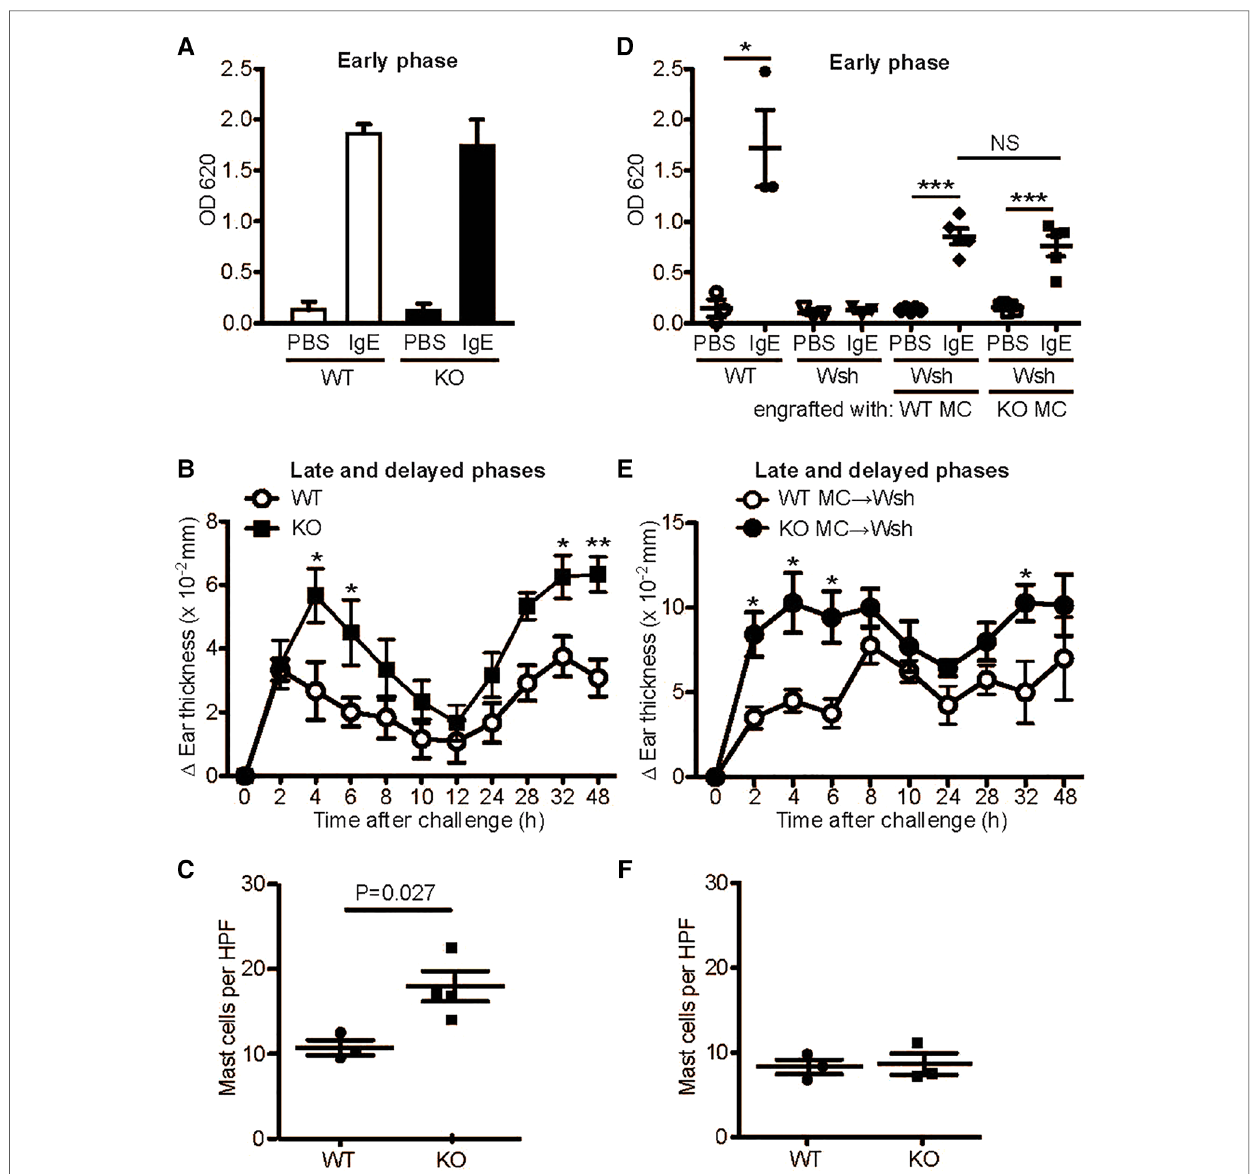
FIGURE 3 MAVS-de fi cient mice exhibit enhanced late and delayed, but normal acute, PCA responses. 6 − 8 week-old WT and MAVS − / − mice ( A-C ) or Kit W − sh/W − sh (Wsh) mice engrafted with WT or MAVS − / − BMMCs ( D-F ) were sensitized by administration of 500 ng anti-DNP IgE or PBS (10 μ l) to each ear. 24 h later, mice were challenged intravenously with 100 μ g DNP 23 -HSA in 100 μ l 1% Evans blue ( A,D ). Evans blue was extracted from the ears 30 min after Ag injection. Alternatively, 10 μ l of 0.3% dinitro fl uorobenzene in acetone and olive oil (4:1) was painted on both sides of ears ( B,E ). Ear thickness was measured. Results representative of three independent experiments using 4 − 6 mice per group are shown. *, **, ***: p <0.05, p <0.01, p <0.001 by Student ’ s t -test. NS, not signi fi cant. ( C,F ) Mast cells in the ear of naïve WT and MAVS − / − mice ( C ) and mast cell-engrafted Kit W − sh/W − sh mice ( F ). Mast cells in the ears were stained by toluidine blue. HPF, high power fi